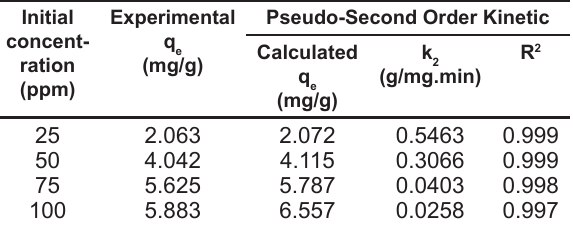
of methylene blue by pyrolusite